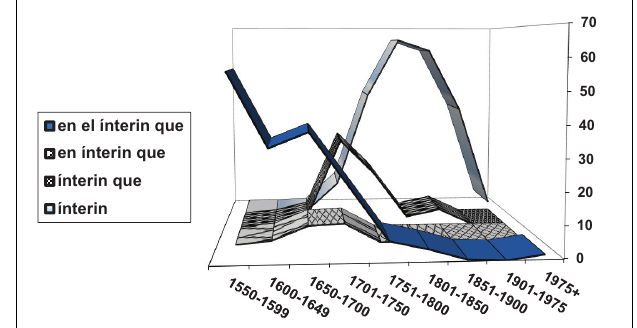
FIGURE 11 | Evolution of relational uses of ínterin “ while” [ lo acabaremos (en (el)) ínterin (que) los demás llegan “we will finish it (in (the)) meantime the others arrive”]: Relative frequency percentages for each construction within each period. Data from